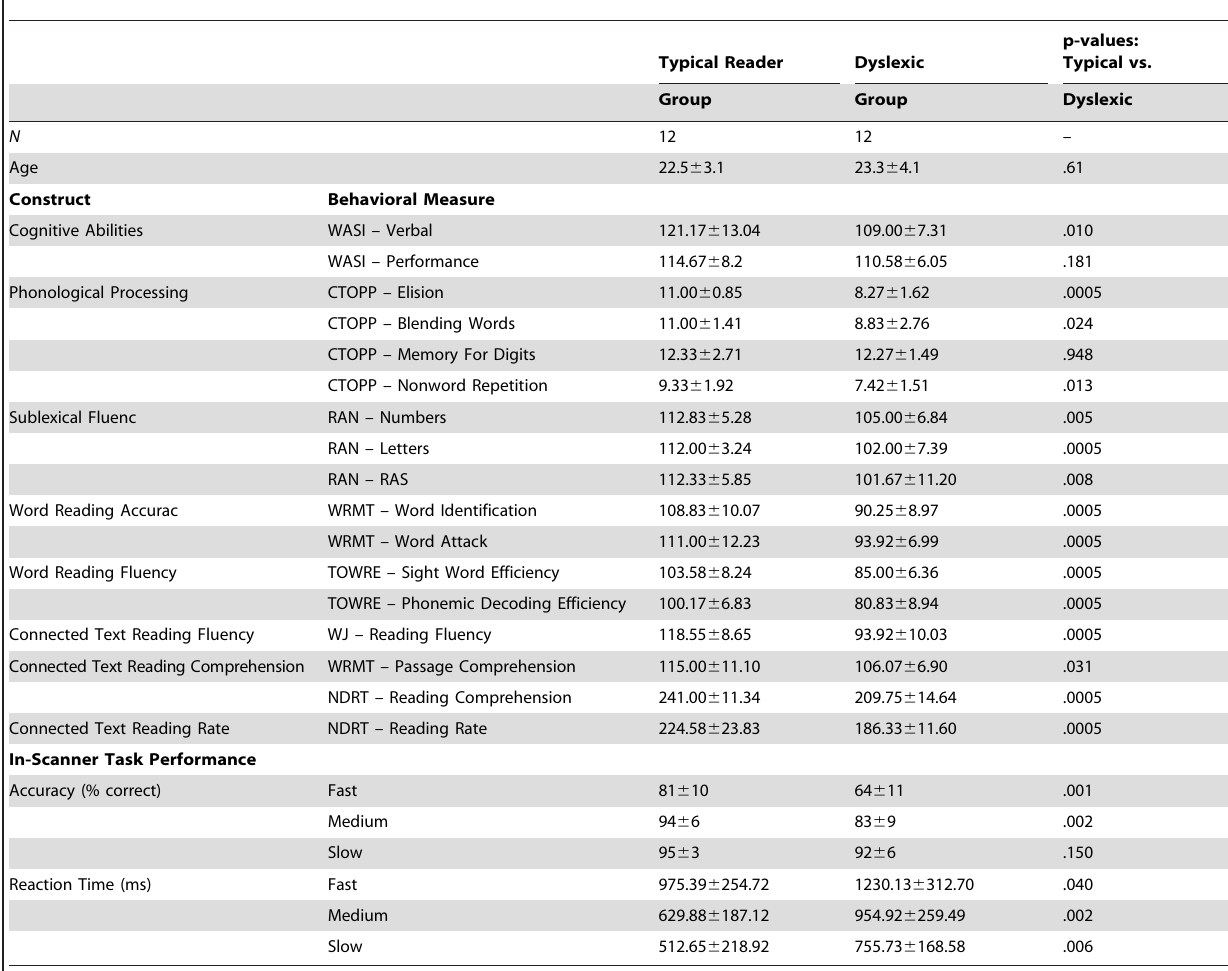
Table 1. Participant Scores for Typical Readers and Readers with